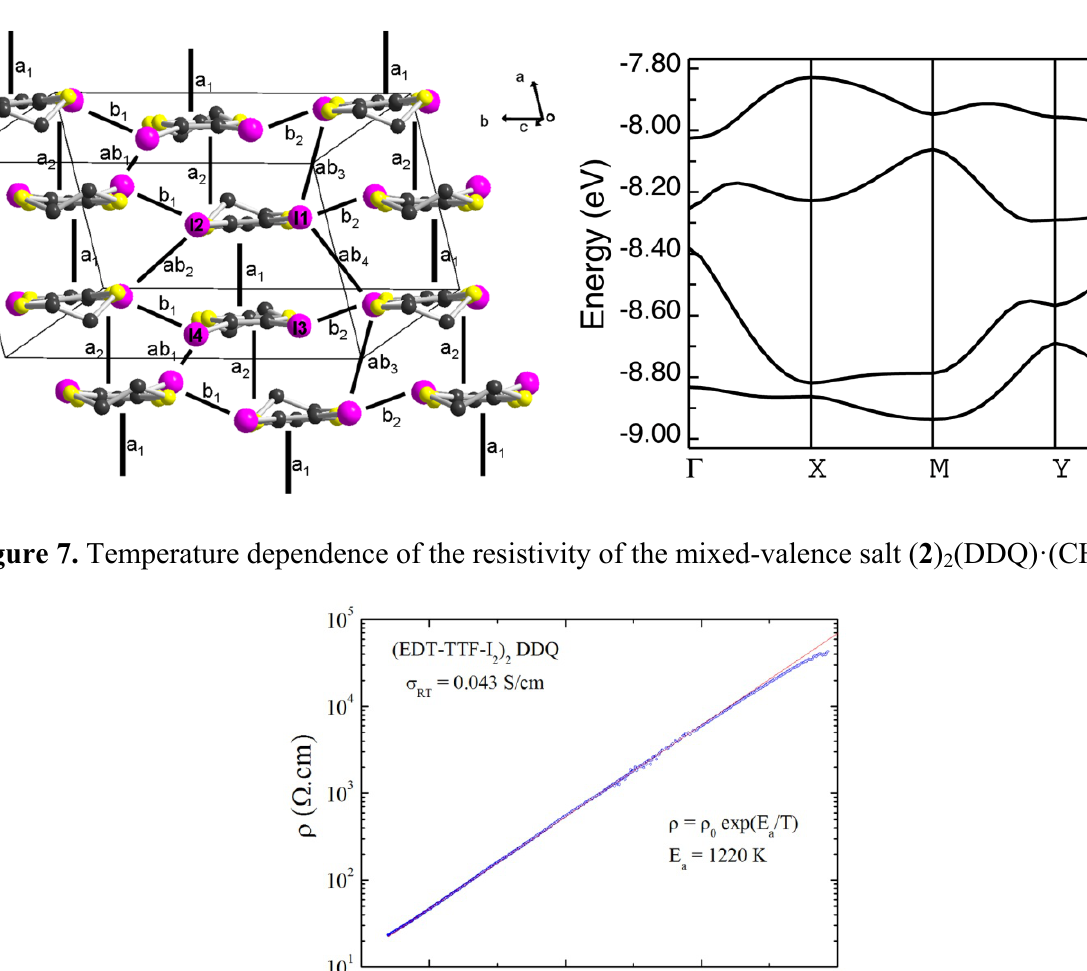
Figure 6. Left: Side view of the slab of partially oxidized 2 molecules in ( 2 ) (DDQ)·(CH CN) together with calculated β interaction energies, 2 3 HOMO − HOMO β = − 0.4742, β = 0.1325, β = 0.0648, β = 0.1341, β = − 0.2596, β = − 0.0482, a1 a2 b1 b2 ab1 ab2 β = 0.1286, β = 0.0797 eV. Right: Calculated band structure; Г = (0, 0), X = (a*/2, 0), ab3 ab4 Y = (0, b*/2), M = (a*/2, b*/2).